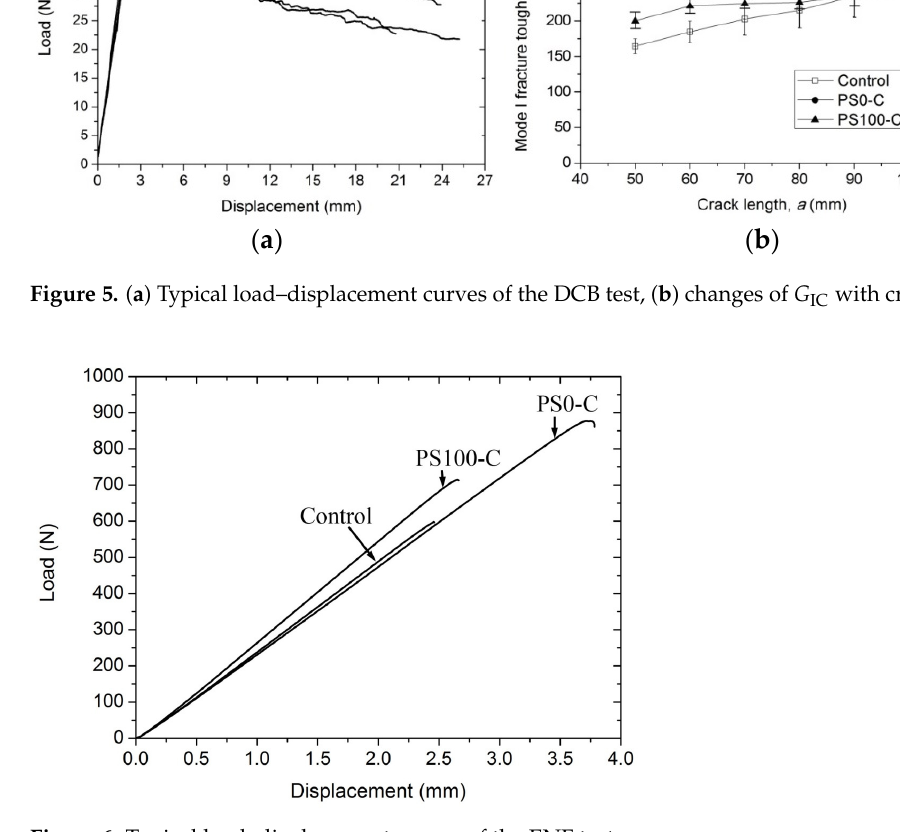
Figure 6. Typical load–displacement curves of the ENF test.